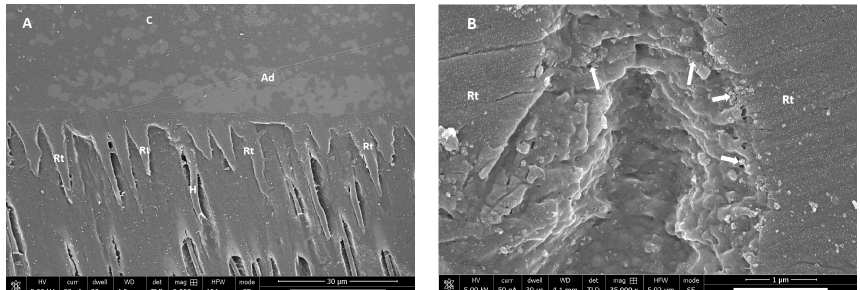
Figure 5. ( A ) Field emission scanning electron microscopic (FESEM) micrograph showing resin–dentin interface using HA-modified experimental dentin adhesive. ( B ) High magnification of hybrid layer showing space between two resin tags. White arrowheads point to homogenous distribution of hydroxyapatite nanoparticles. C: Composite, Ad: Adhesive, H: Hybrid layer, Rt: Resin tags.